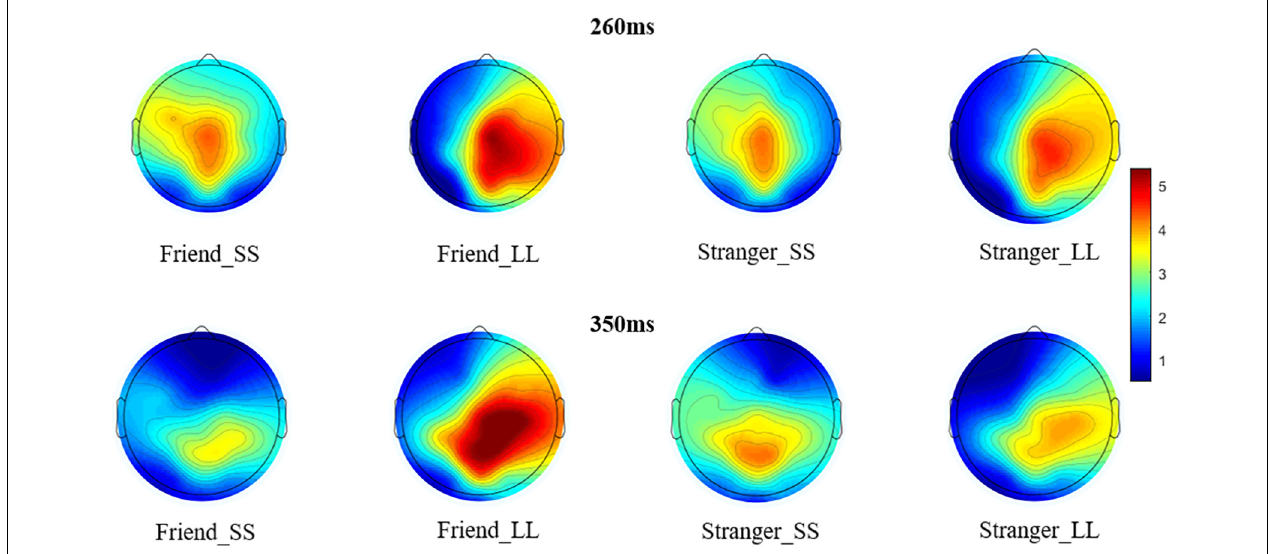
FIGURE 4 | The brain topographic voltage maps at 260 ms and 350 ms under four conditions.